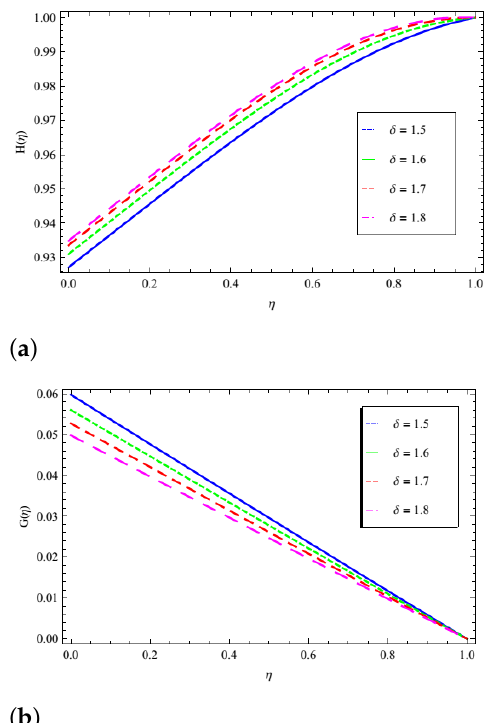
Figure 5. Impact of δ on ( a ) homogeneous reaction H ( η ) and ( b ) heterogeneous reaction G ( η ) for specific values S = − 2.5, K 1 = K 2 = Ha = R = 0.1, Q = 10, P r = Sc = L =